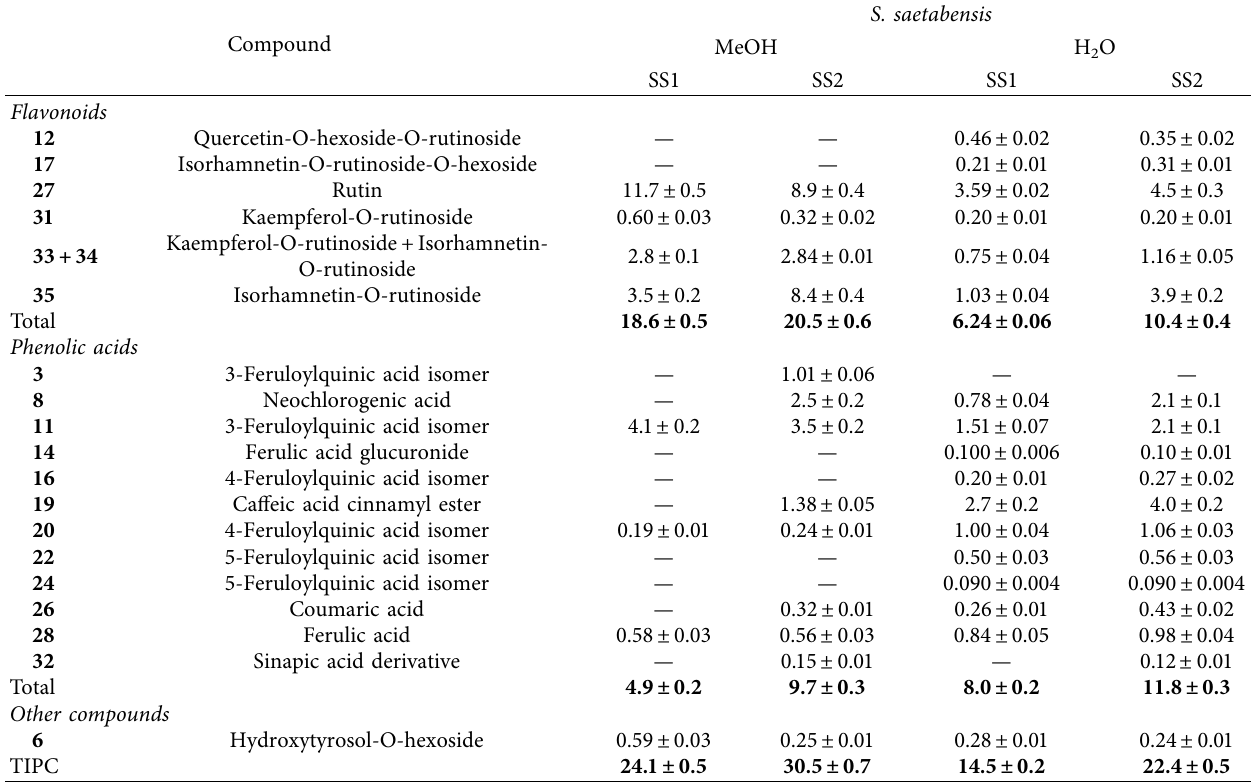
Table 5: Quantification of compounds in extracts of S. saetabensis (SS) from two different locations, extracted in methanol and water.